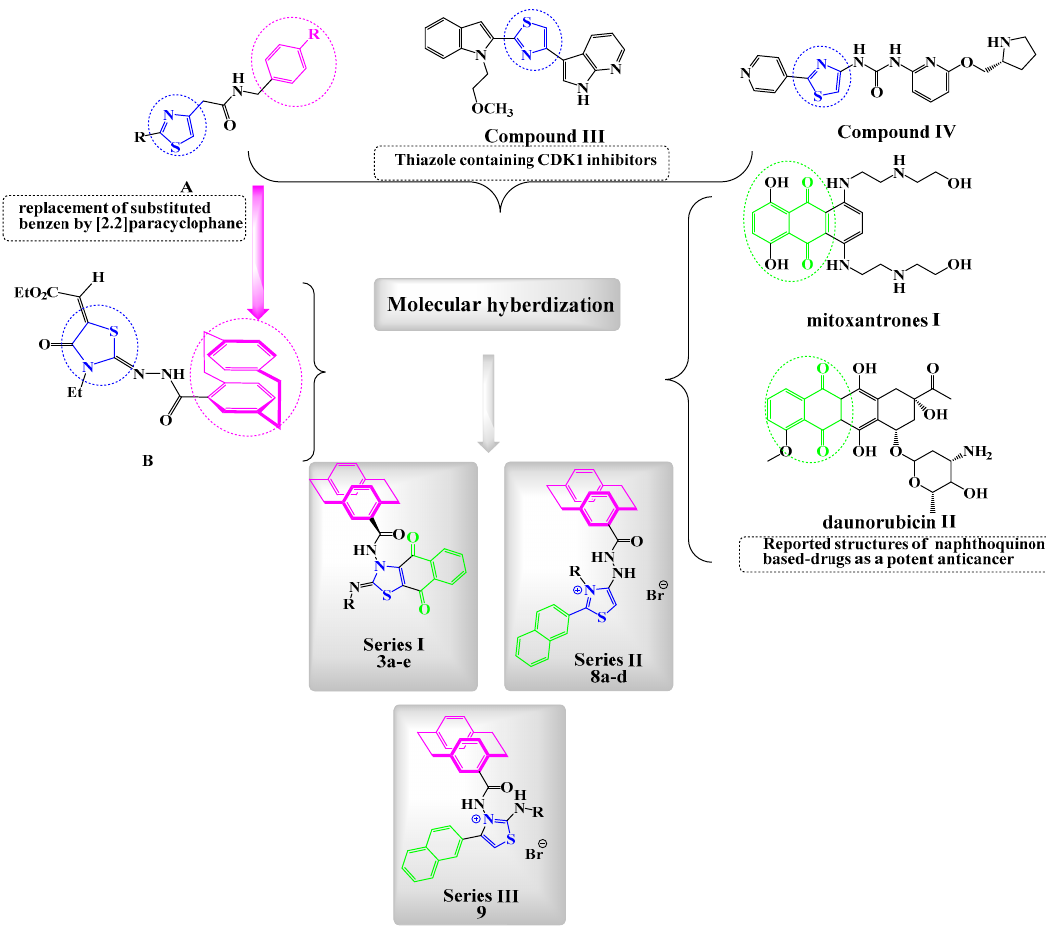
Figure 1. Reported antitumor 1,4-naphthoquinones, thiazoles, and [2.2]paracyclophane derivatives ( I – IV ), along with benzylic-thiazoles A and paracyclophanylthiazole B and the new designed compounds: series I ( 3a – e ), series II ( 8a – d ), and series III ( 9 ). CDK: cyclin-dependent